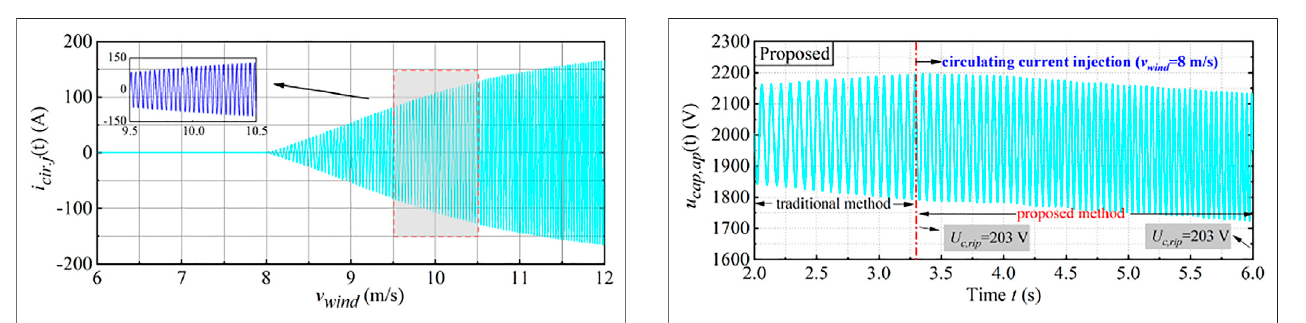
FIGURE 13 | Actual injection circulating current waveform.